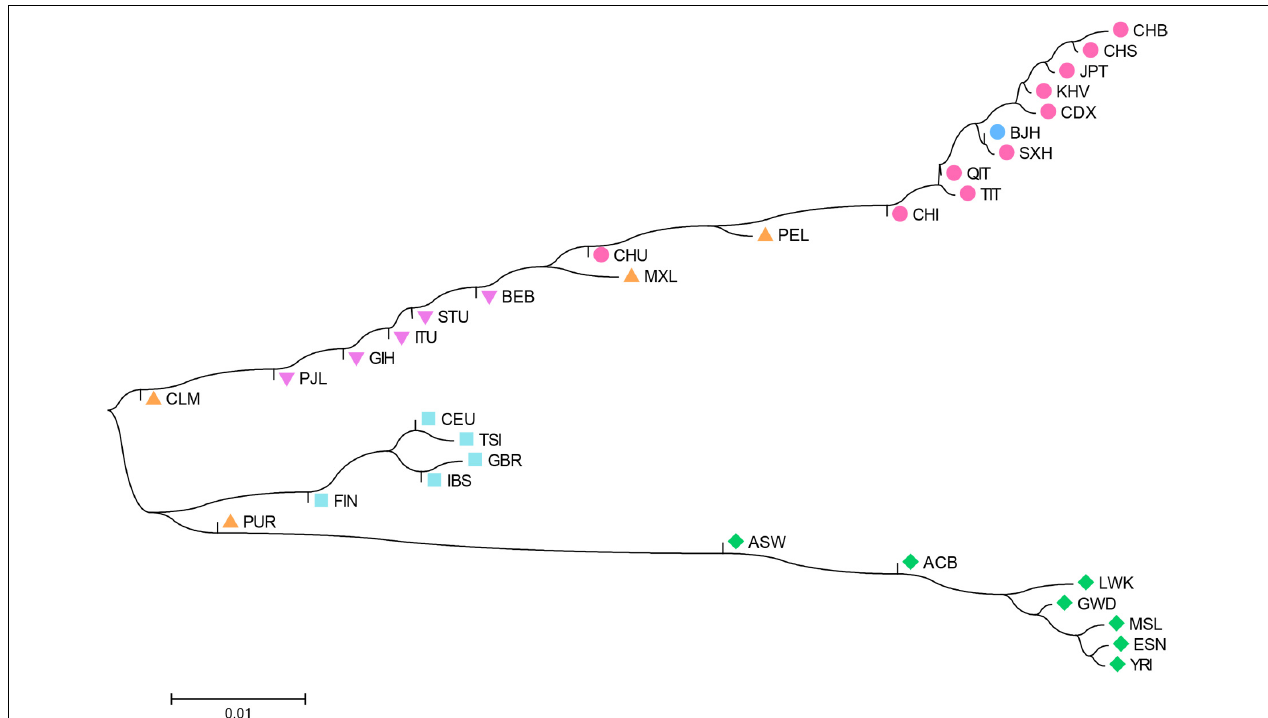
FIGURE 4 | The phylogenetic tree conducted on the basis of the pairwise D A distances among the Beijing Han population and 31 reference